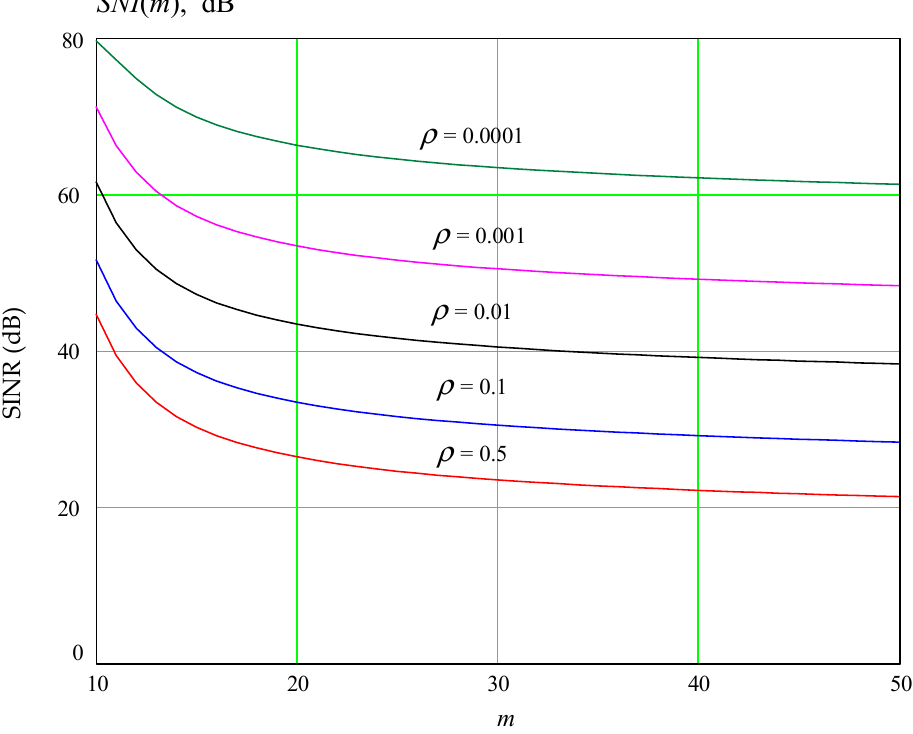
Figure 4. Dependence of SINR on the number of network nodes and load intensity.